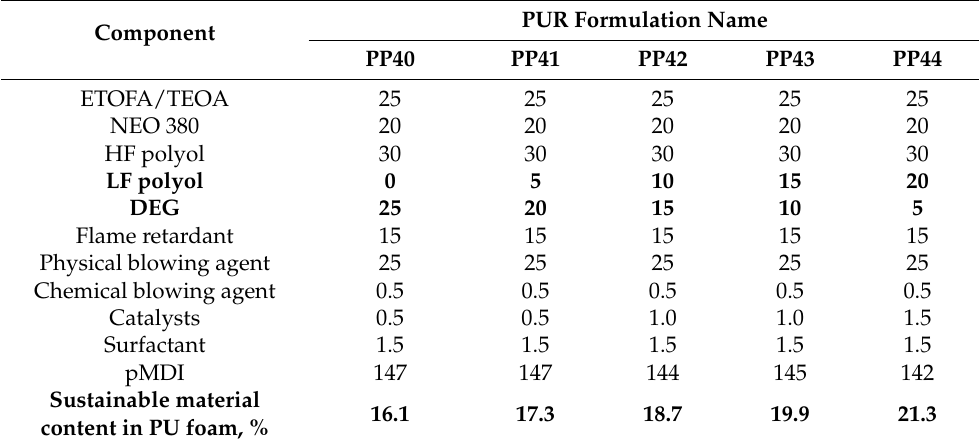
Table 2. Formulations of rigid PUR